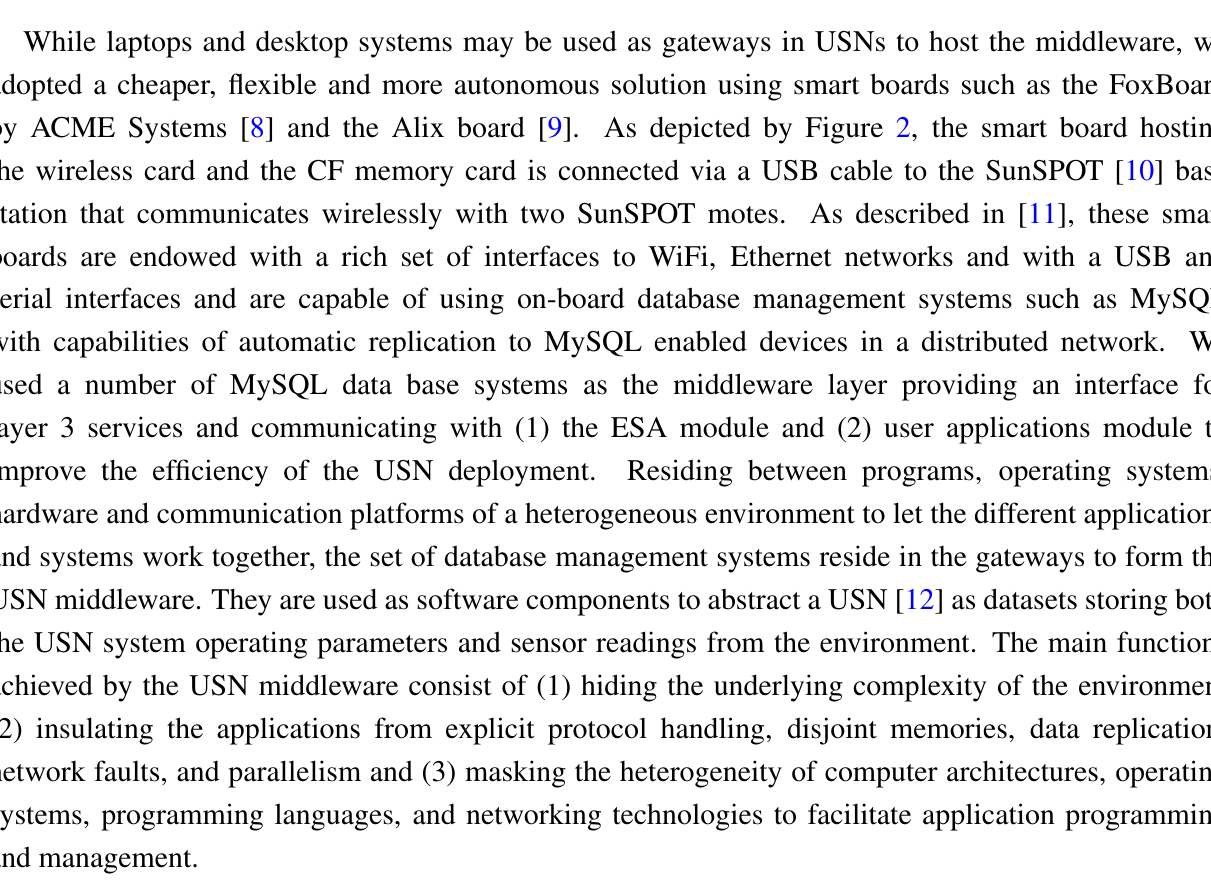
Figure 2. A Smart Board Connected to SUNSpot